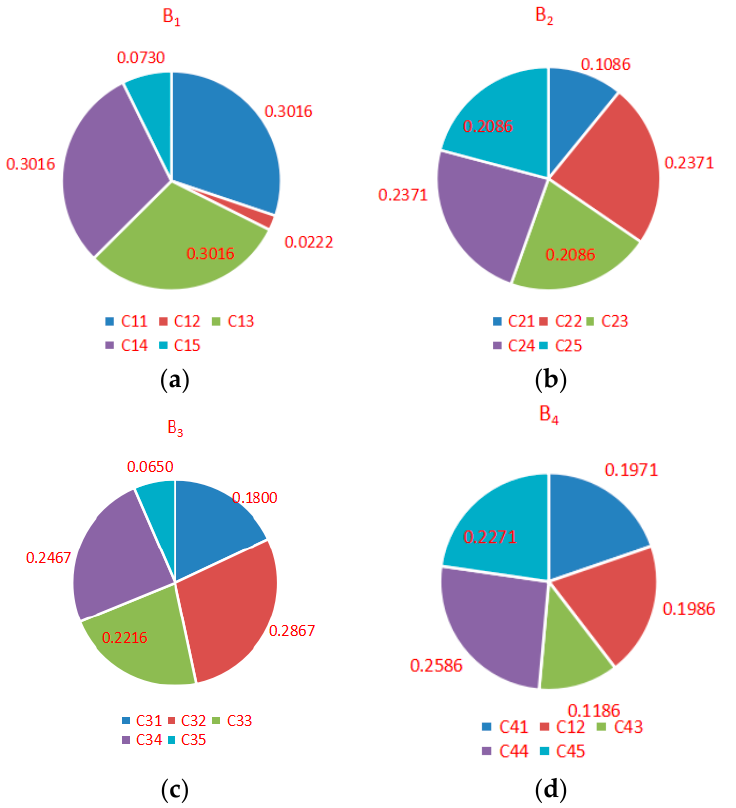
Figure 2. The weighting diagram of the criterion layer indicators.